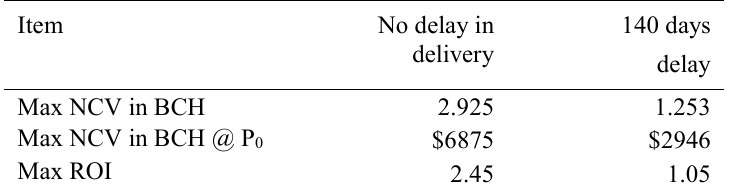
Table 2. Effect of Delay on